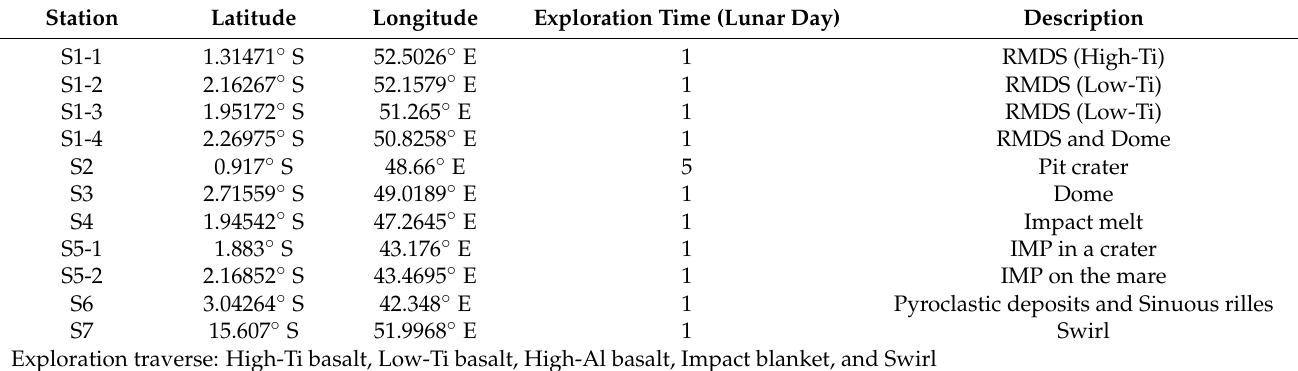
Table 2. Stations of the long-distance detection traverse in Mare